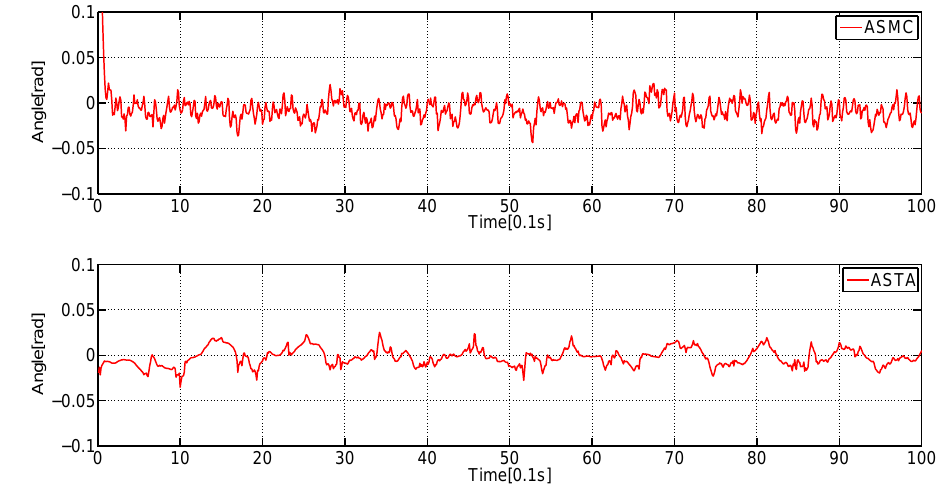
Figure 4. Comparison of the angles in Case 1.